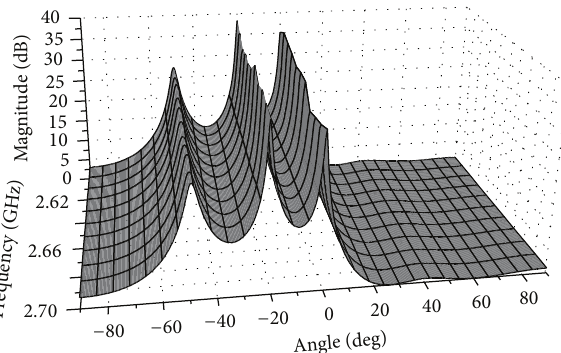
Figure 8: Spatial spectra of the MUSIC algorithm for three wide- band signals at all subbands. The fitted compensation matrices in the frequency band are employed.